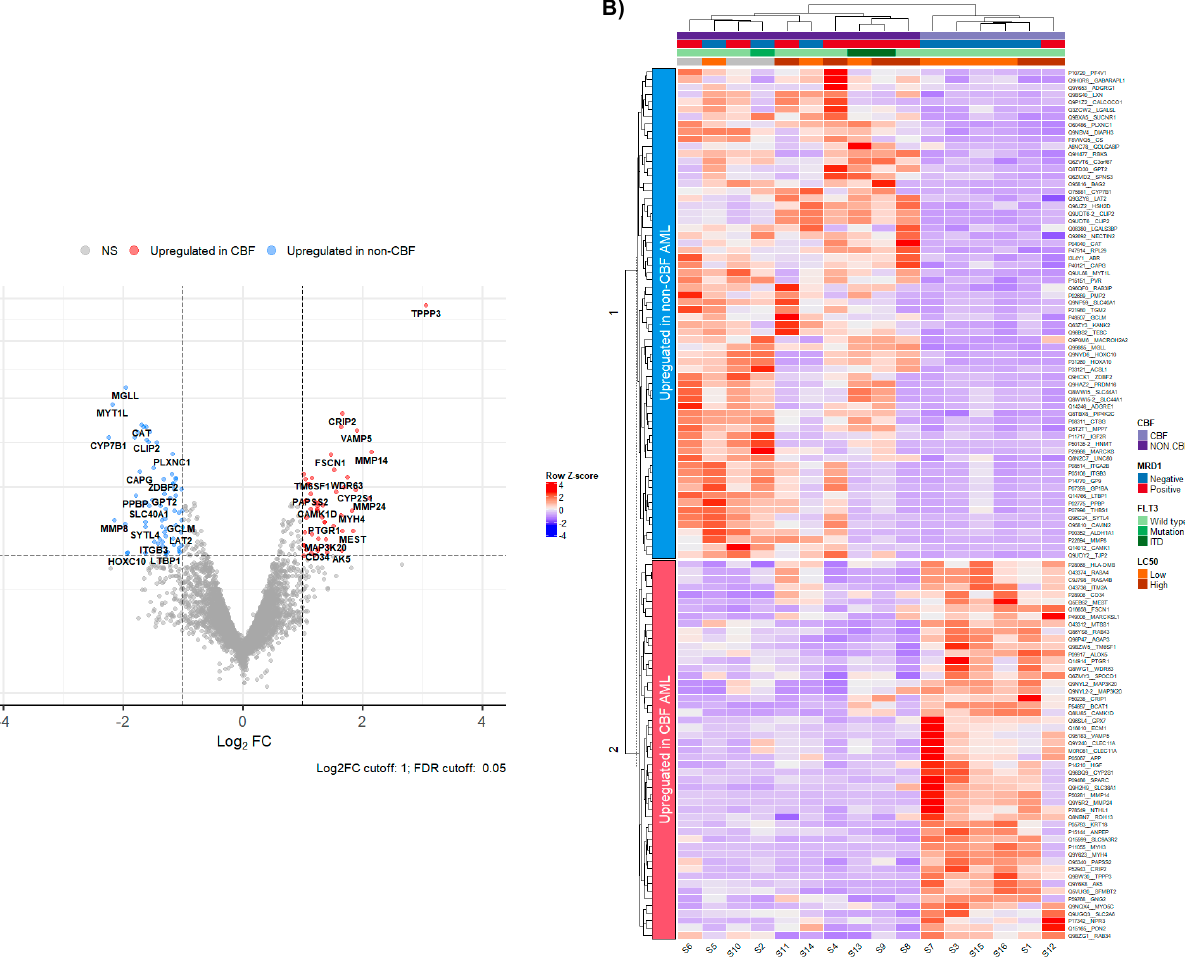
Figure 1. Leukemic cell proteomic profiles comparing CBF AML with non-CBF AML patients: ( A ) Volcano plot illustrating differentially regulated protein expression in patients with CBF AML ( n = 6) compared with non-CBF AML ( n = 10). Differential protein expression revealed a total of 51 upregulated proteins in CBF (red) and 66 upregulated proteins in non-CBF (blue) (FDR < 0.05, |Log2FC| > 1); ( B ) Heatmap with hierarchical clustering of the 117 differentially expressed proteins between CBF and non-CBF AML, color scaled by row Z-score indicates relative expression (high levels of expression in red and low levels of expression in blue).